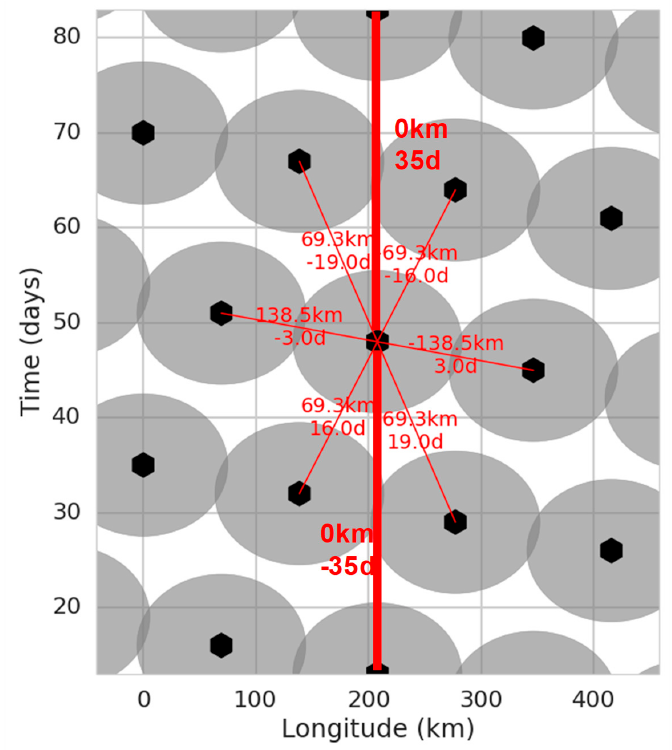
Figure 1. Longitude of Advanced Research and Global Observation Satellite (ARGOS) and AltiKa (SARAL/AltiKa) ascending tracks at 30°N as a function of time (black dots). The grey circles are 150 km by 15 days (typical decorrelation scale of ocean mesoscale). The red lines highlight the main orbit sub-cycles (major: 3 days, 16 days, minor: 19 days) as well as the 35-day repeat cycle of the European Remote-sensing Satellite (ERS)/ENVIronment SATellite (ENVISAT)/SARAL orbit.